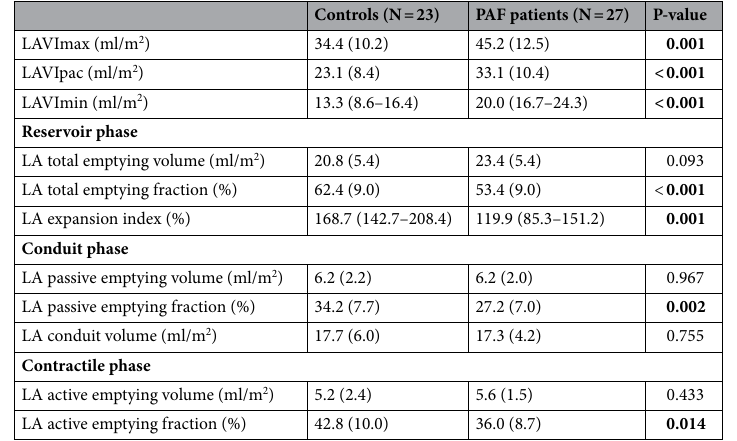
Table 2. Comparison of left atrial function between PAF patients and controls. Significant values are in bold. Variables are expressed as mean (standard deviation) or median (interquartile range) for normally and non- normally distributed continuous variables. I indexed, LA left atrium, LAV LA volume, max maximum, pac pre-atrial contraction, PAF paroxysmal atrial fibrillation, min minimum.